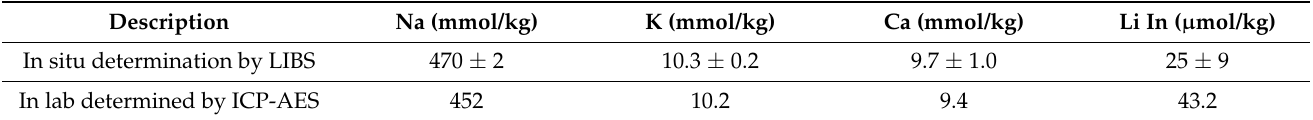
Table 4. Comparison of seawater composition determined by in situ determination by LIBS probe and analysis of the samples in the vicinity by ICP-AES in a laboratory